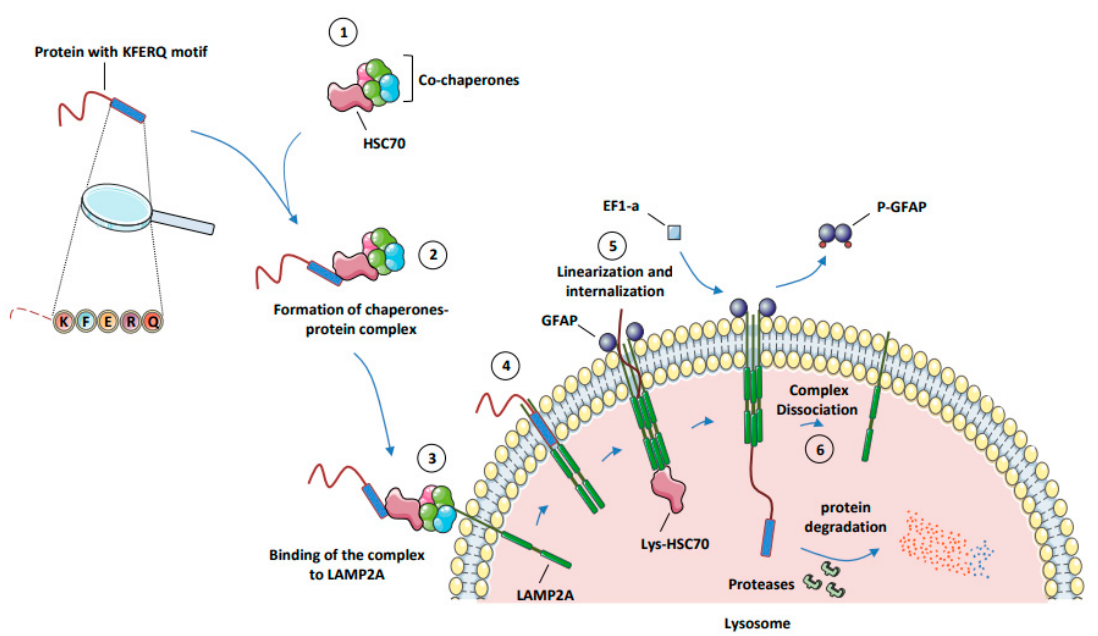
Figure 2. The different steps of CMA. ( 1 ) Formation of protein complex (Hsc70 + co-chaperones). ( 2 ) Formation of the chaperone protein complex (Hsc70 complex + protein substrate). ( 3 ) Binding of the substrate–chaperone complex to LAMP2A. ( 4 ) Assembly of LAMP2A subunits to form a channel in the lysosomal membrane. ( 5 ) Linearization, internalization, and degradation of the protein substrate into the lysosome. ( 6 ) Dissociation of LAMP2A multimer. Abbreviations: CMA, chaperone-mediated autophagy; EF1- α , elongation factor 1 α ; GFAP, glial fibrillary acidic protein; Hsc70, heat-shock cognate protein of 70 kDa; LAMP2A, lysosome-associated membrane protein type 2A; Lys-Hsc70, lysosome-associated hsc70.